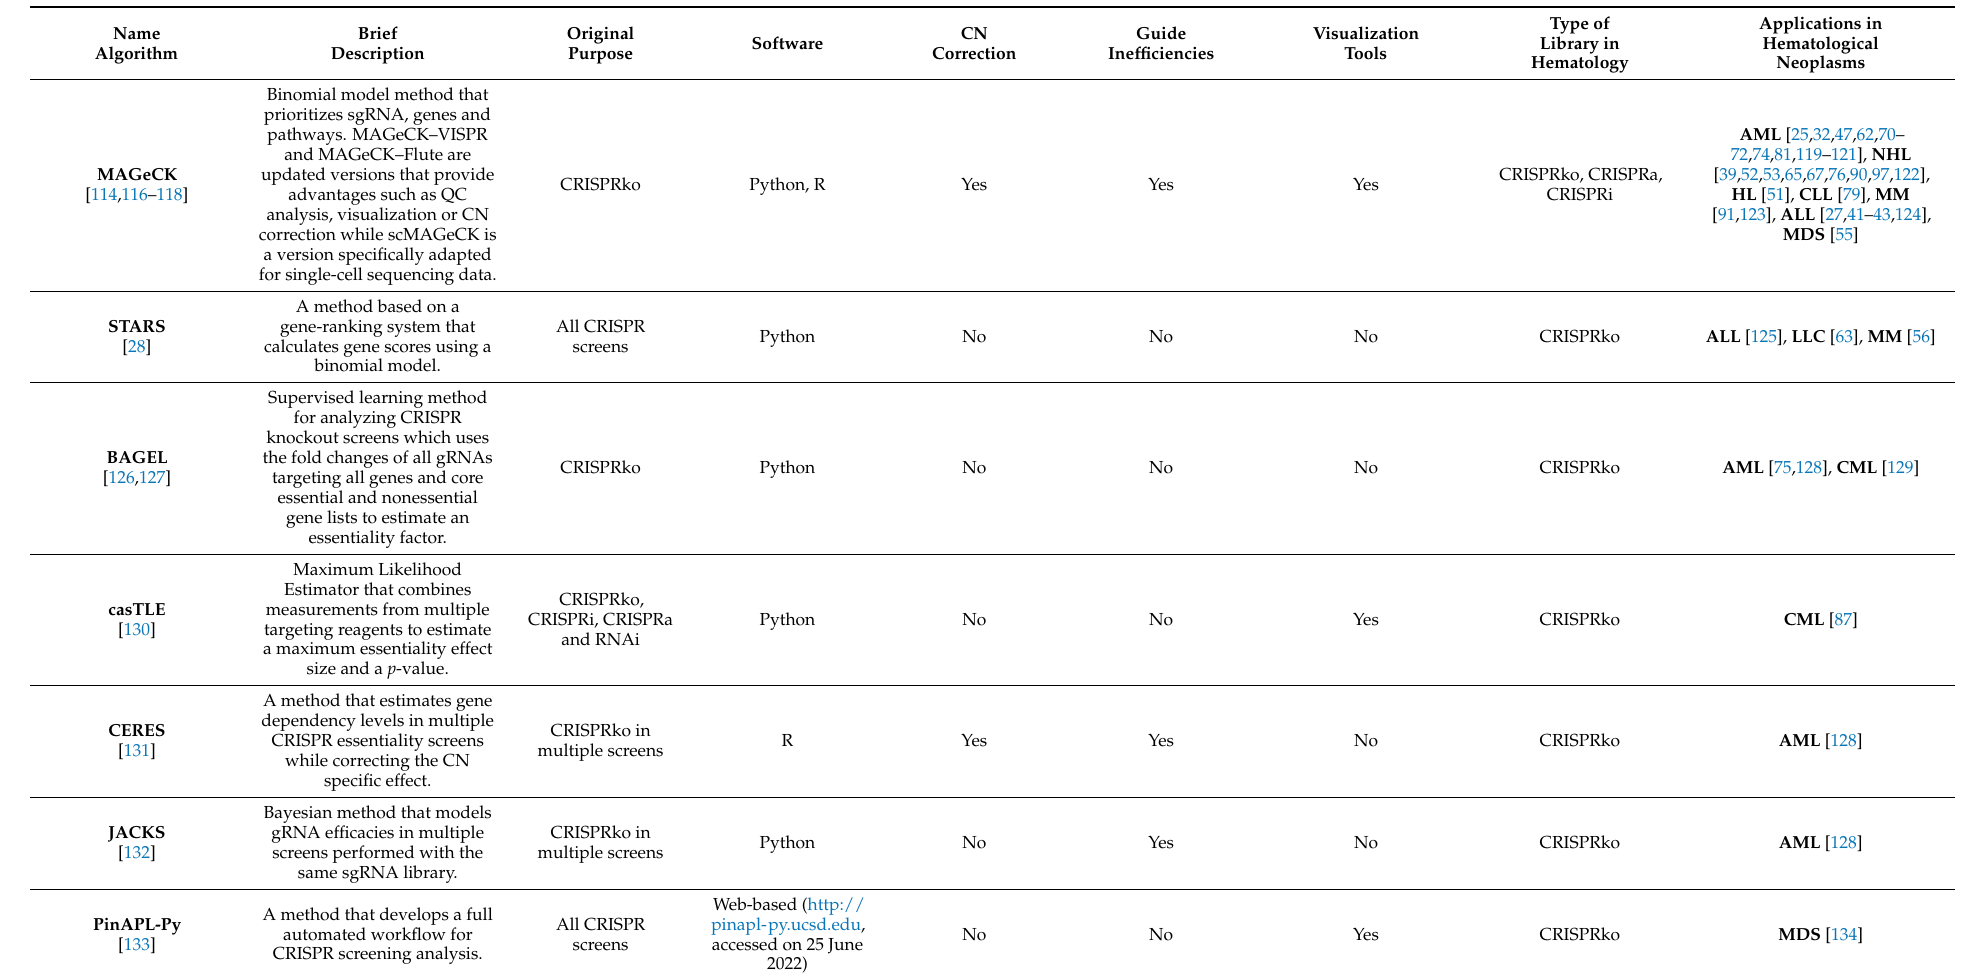
Table 2. Bioinformatic tools for CRISPR screening in